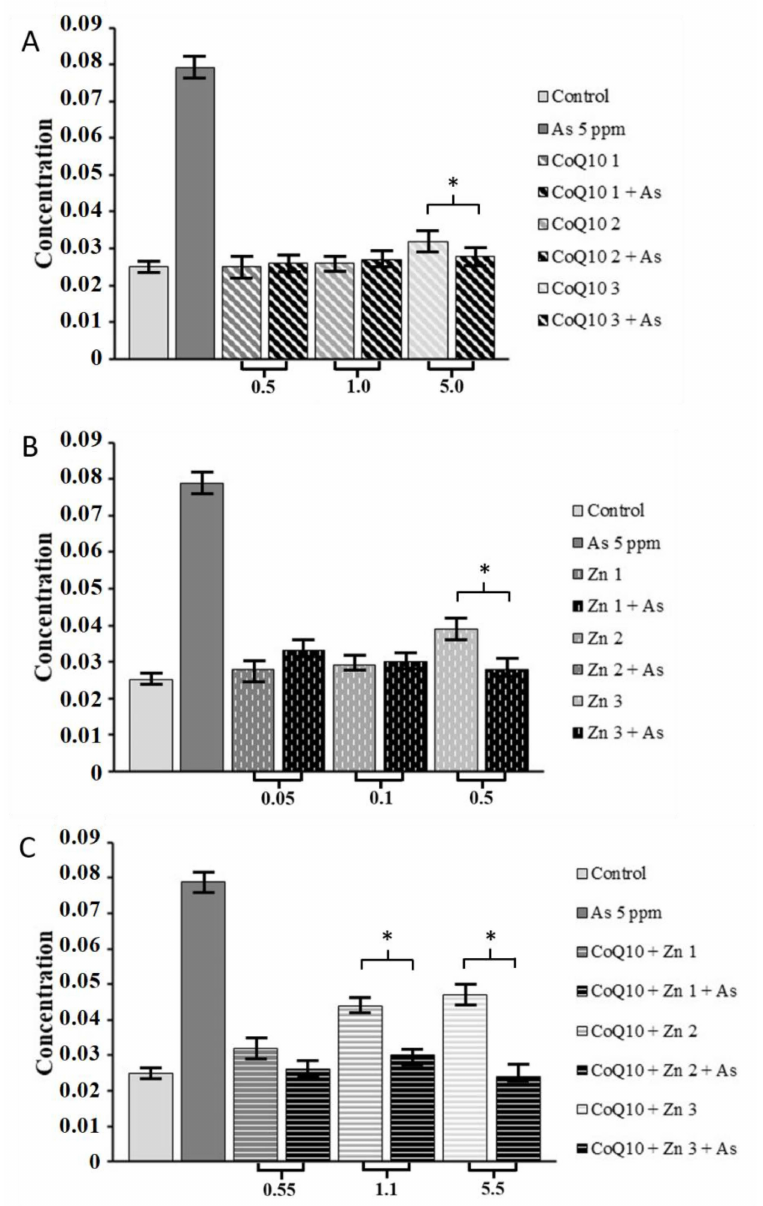
Figure 6. Determination of concentration of aqueous hydroperoxide in the presence of As at 5 ppm at concentrations different. ( A ) of CoQ10 1 at 0.5 mg/mL, CoQ10 2 at 1.0 mg/mL and CoQ10 3 at 5.0 mg/mL; ( B ) of Zn 1 at 0.05 mg/mL, Zn 2 at 0.1 mg/mL and Zn 3 at 0.5 mg/mL; and ( C ) at CoQ10 + Zn 1 at 0.5 + 0.05 mg/mL, CoQ10 + Zn 2 at 1.0 + 0.1 mg/mL and CoQ10 + Zn 3 at 5.0 + 0.5